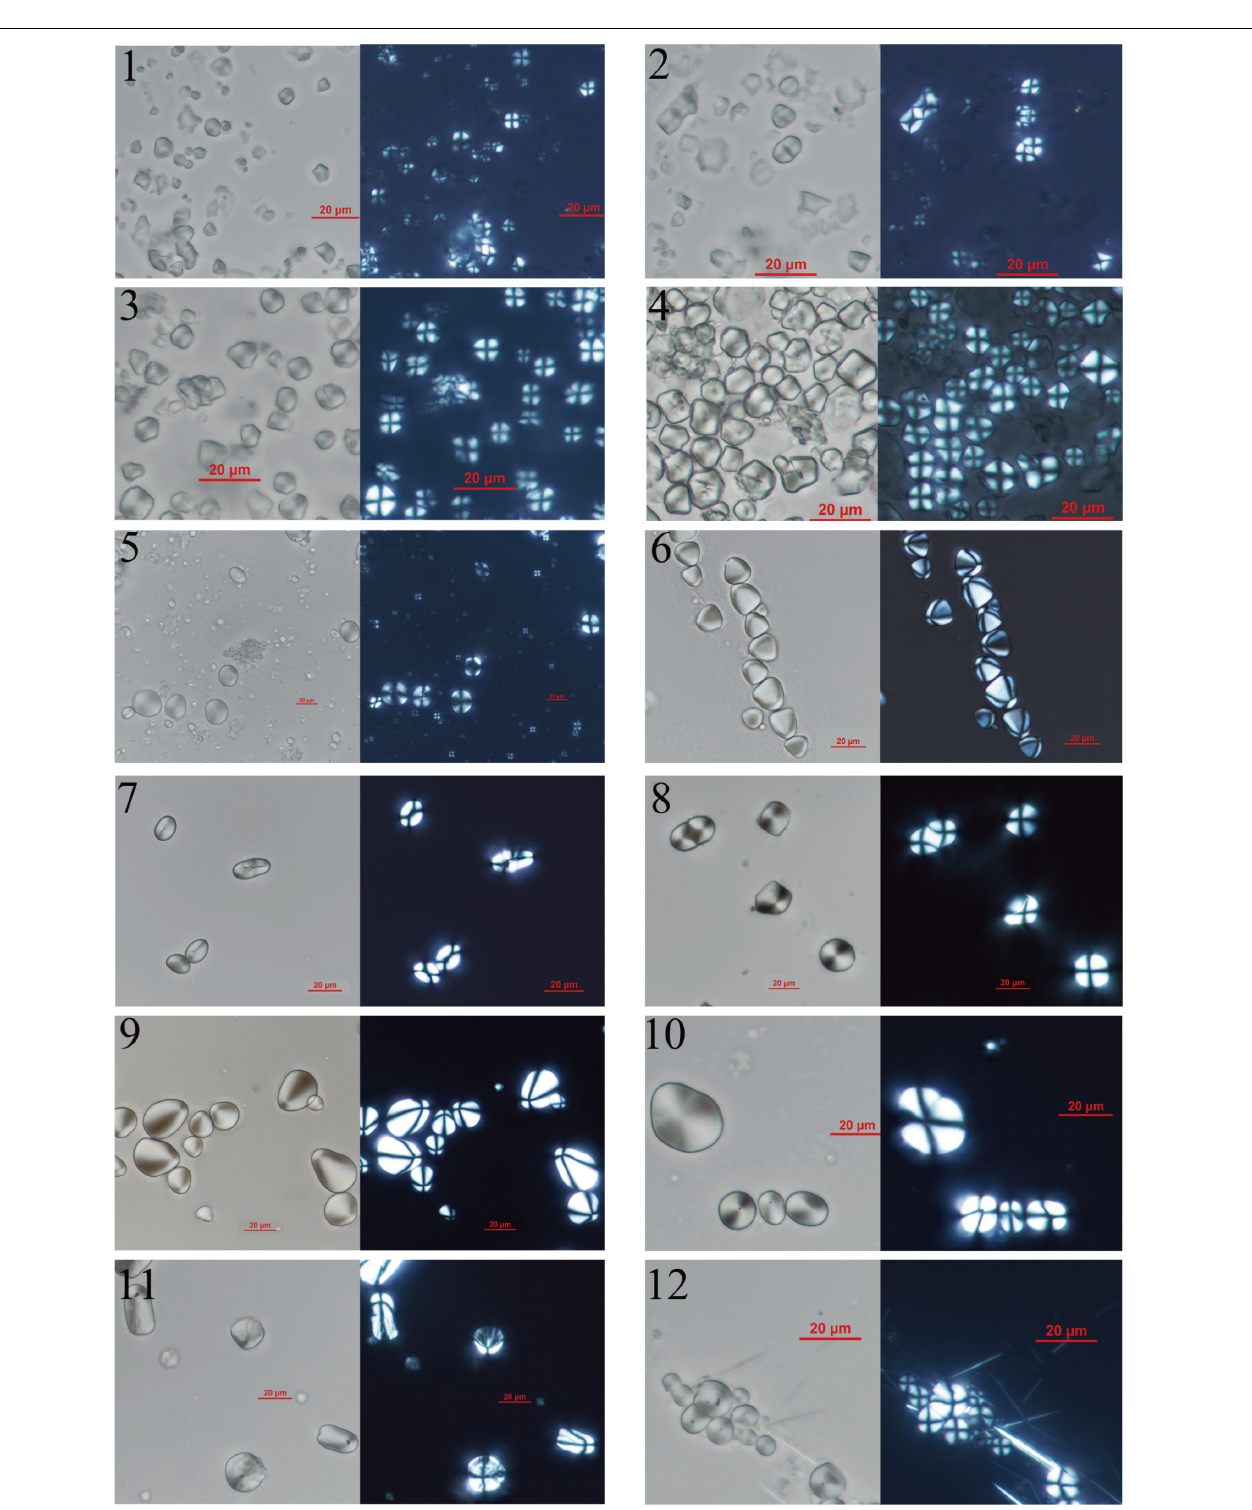
FIGURE 3 | Modern plant starch references included in this paper. [ 1 – 2 , Oryza sativa ; 3 , Panicum miliaceum ; 4 , Setaria italica ; 5 , Triticum aestivum ; 6 , Dioscorea opposita ; 7 , Vigna vexillata ; 8 , Smilax china ; 9 , Bolbostemma paniculatum ; 10 , Trapa bispinosa ; 11 , Nelumbo nucifera (root); and 12 , Pinellia ternate ].